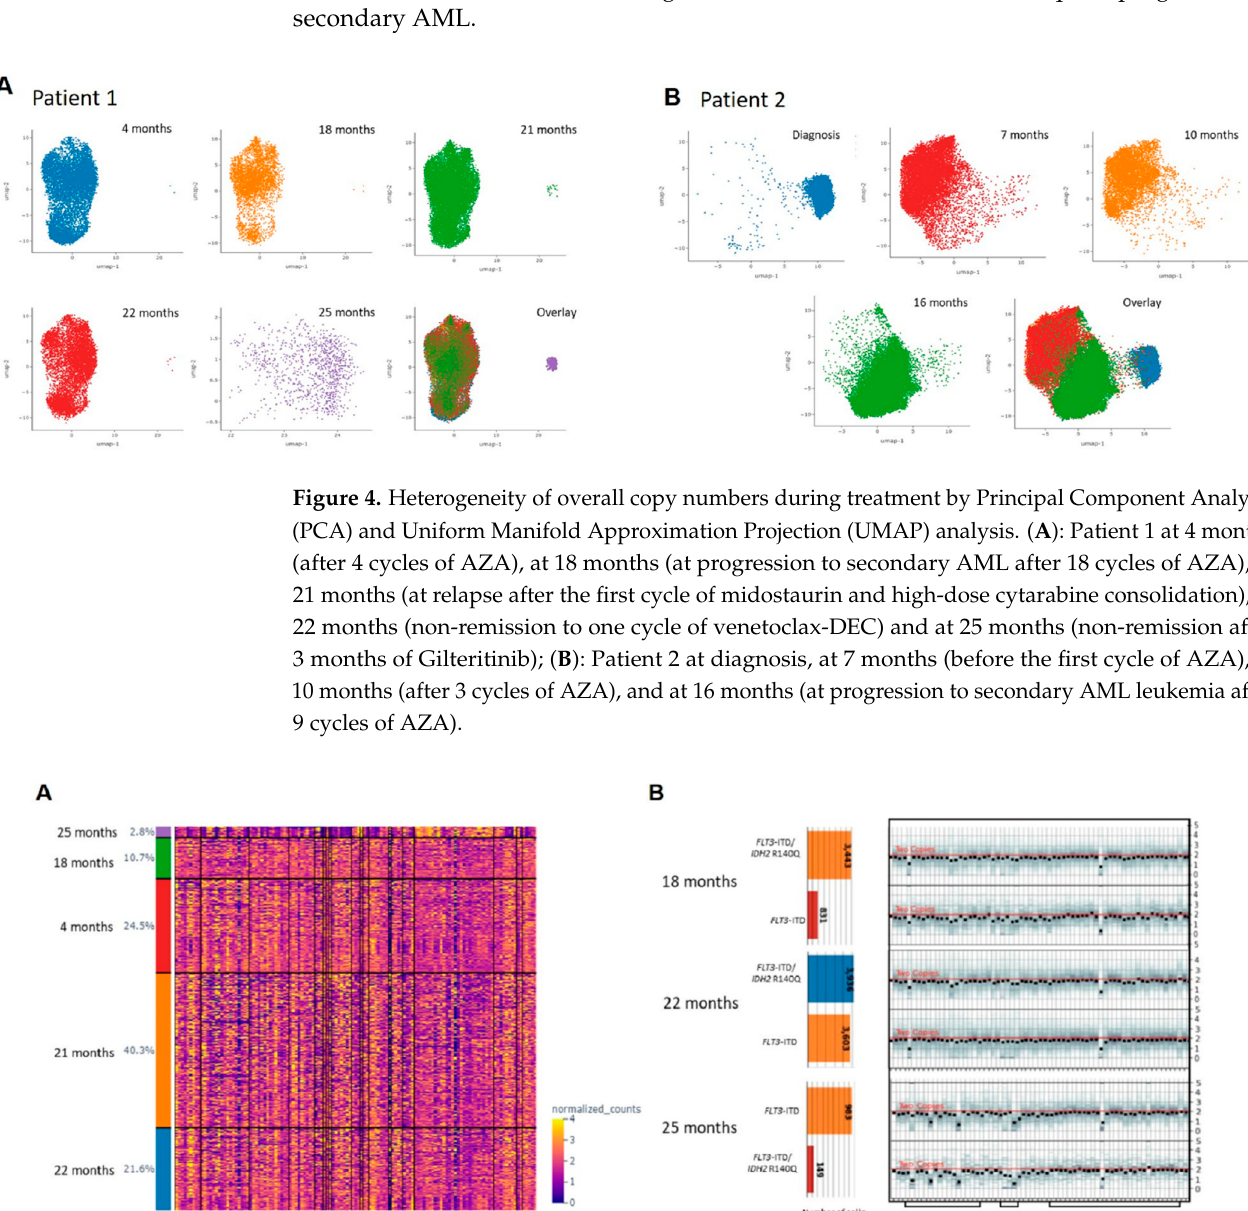
Figure 5. Co-occurrence of SNVs and short INDELs with CNVs in Patient 1. ( A ): merged CNV analysis of all time points; ( B ): Gradual copy number loss of DNMT3A, GATA2, and TET2 at 18 months (at progression to secondary AML after 18 cycles of AZA), at 22 months (non-remission to one cycle of venetoclax-DEC) and at 25 months (non-remission after 3 months of